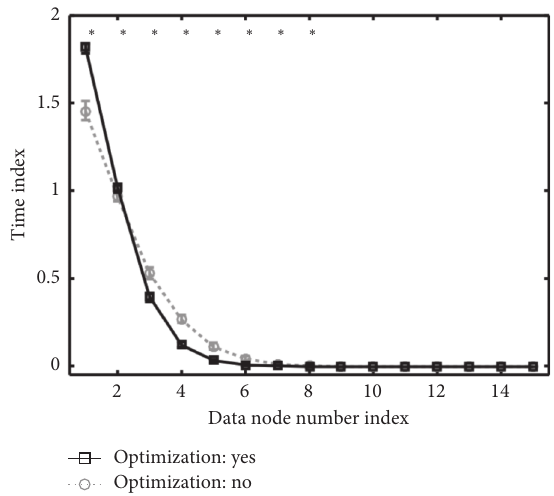
Figure 4: MapReduce for collaborative filtering. Table 3: The extension mining method for extension architectural image planning. Extension architectural image